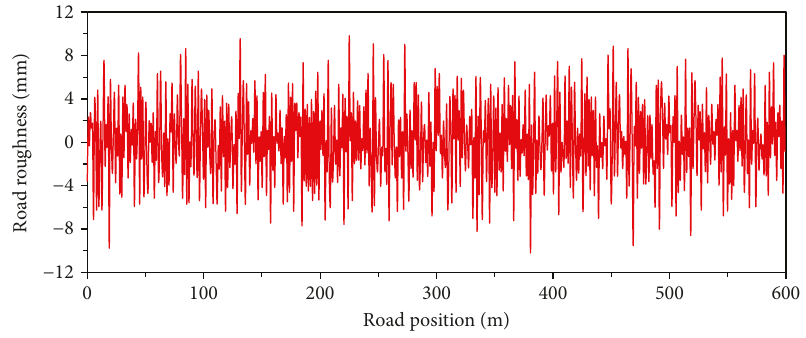
Figure 5: Bridge deck roughness of long-span